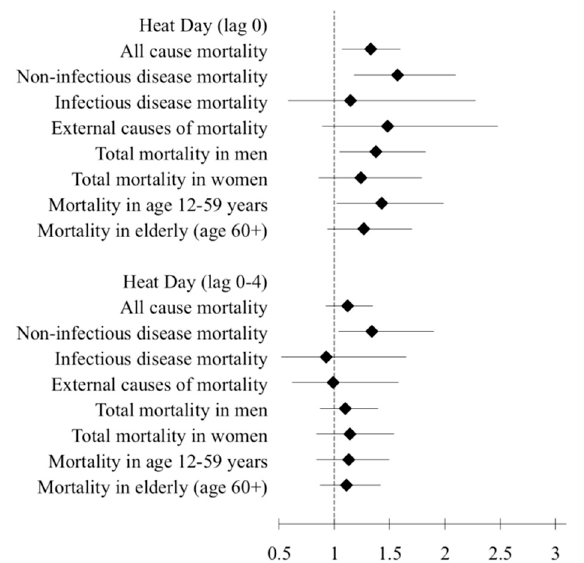
Figure 2. Association of heat (98th percentile, >39 °C) with total, cause-specific, age and sex-specific mortality in Vadu HDSS 2003–2012.